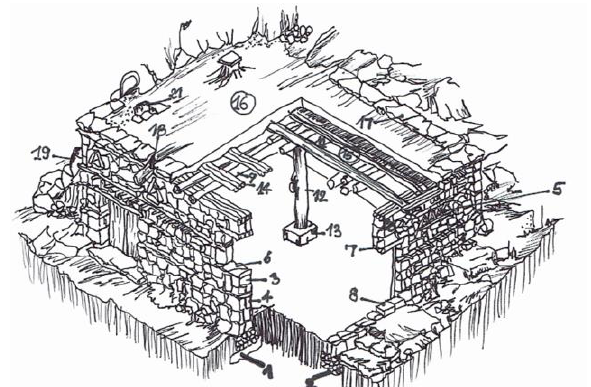
Figure 8. Details of a Berber house. Drawing from LEBBAL (1989 ), “Traditional Berber Architecture”.